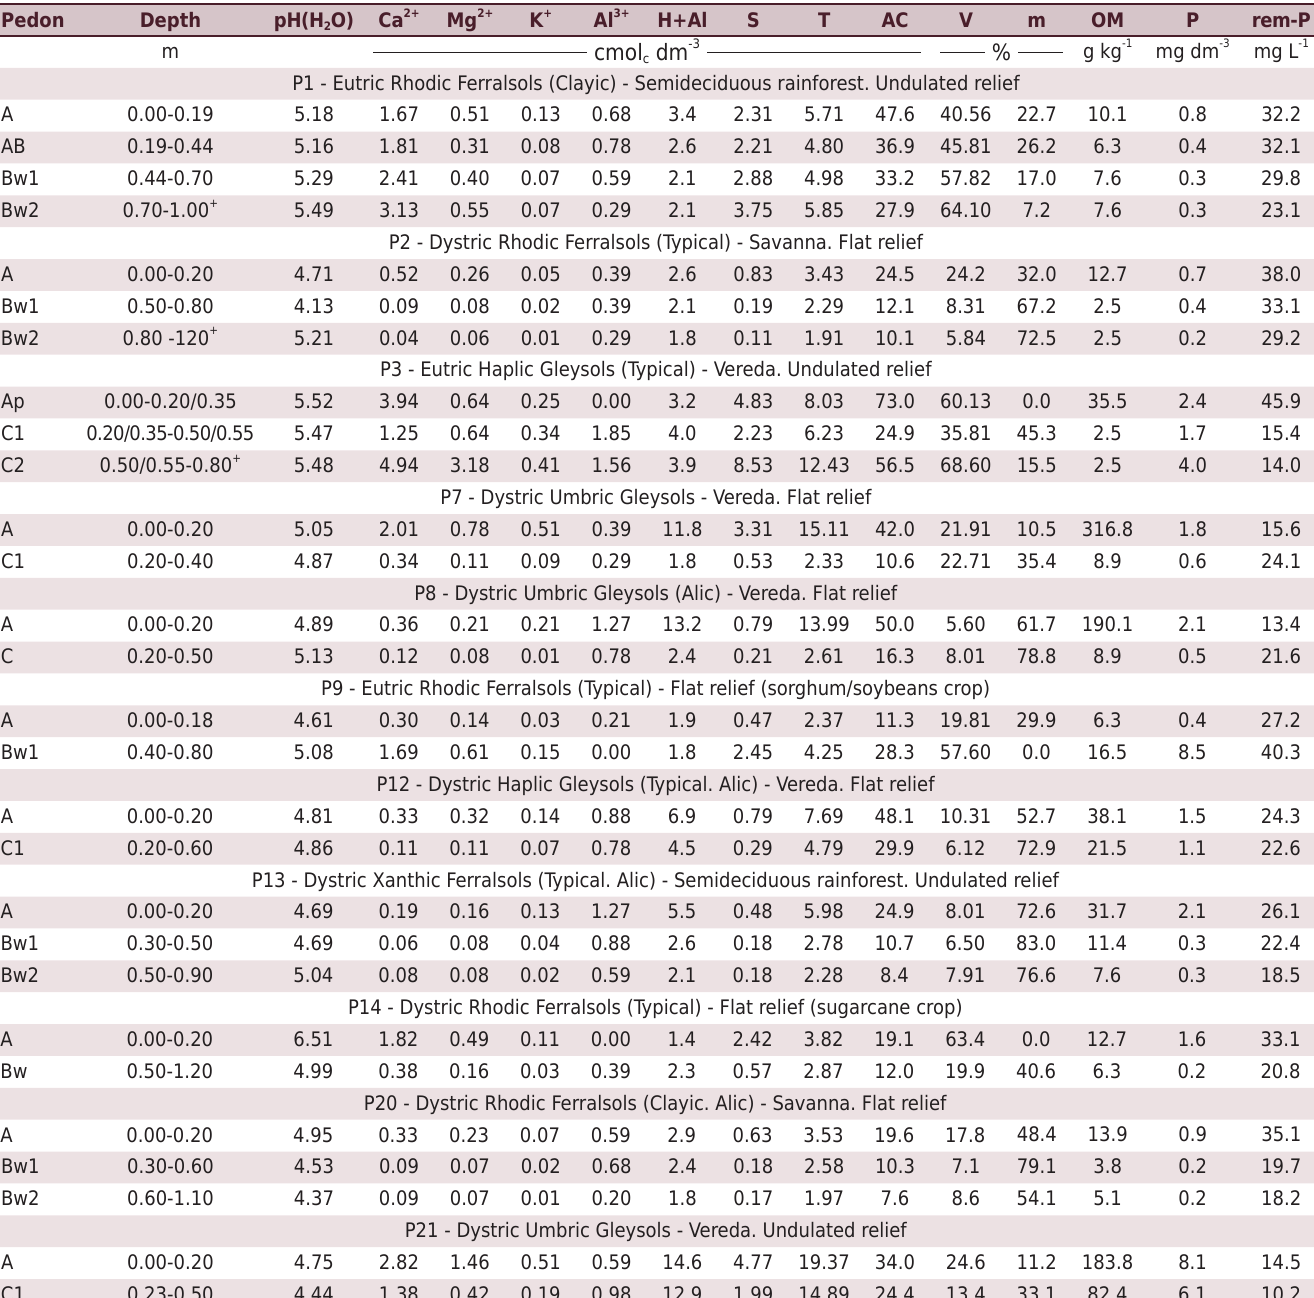
Table 5. Chemical properties of the studied soils Pedon Depth pH(H 2 O) Ca 2+